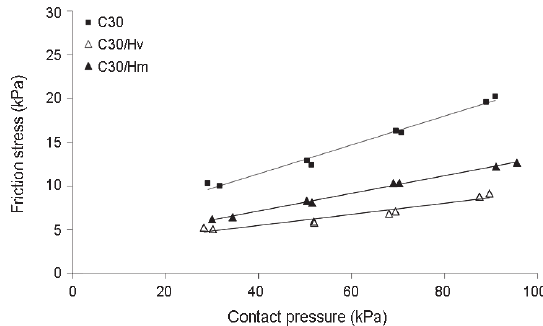
Fig. 9. Evolution of friction stress as a function of contact pressure for C30 with release agent